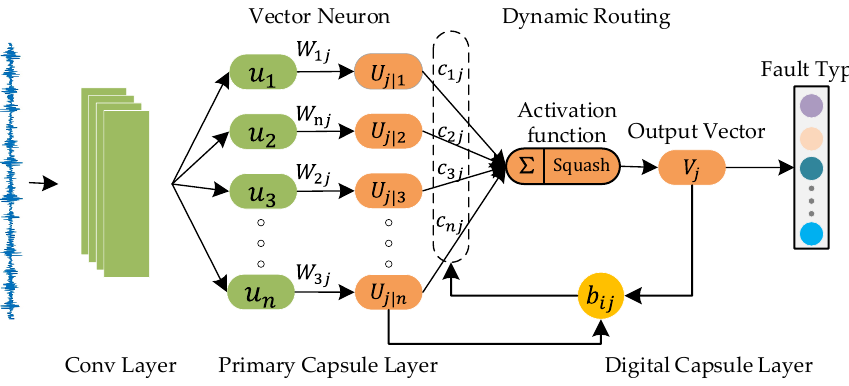
Figure 1. The architecture of a capsule network. The transformation of scalar neurons into vector neurons occurs in the primary capsule layer. Dynamic routing occurs between the primary capsule layer and the digital capsule layer.